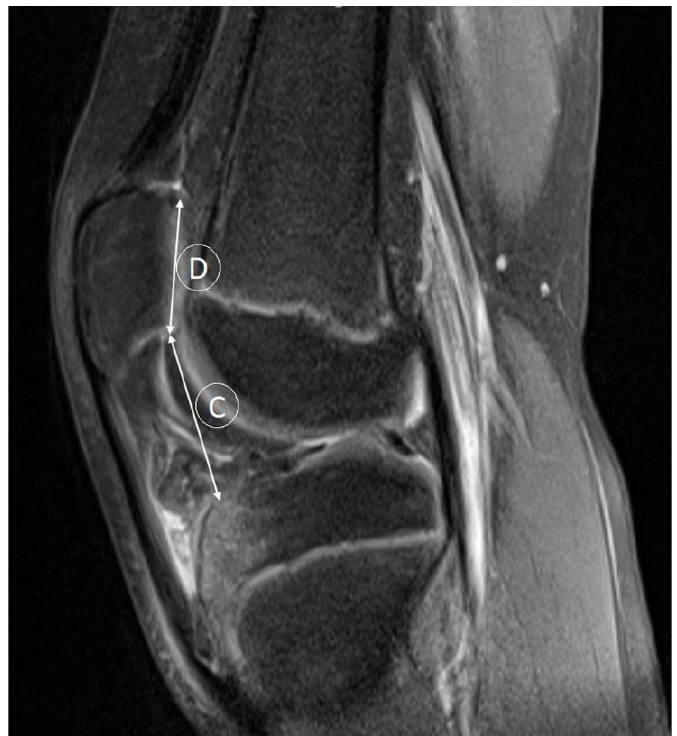
Figure 4. Patellar Caton–Deschamps index (C:D). C—distance from the inferior margin of the patellar articular surface, D—patellar tendon insertion length of the patellar articular surface (described in the section Materials and Methods) Table 4. Morphometric parameters by patellar type (Wiberg classification).